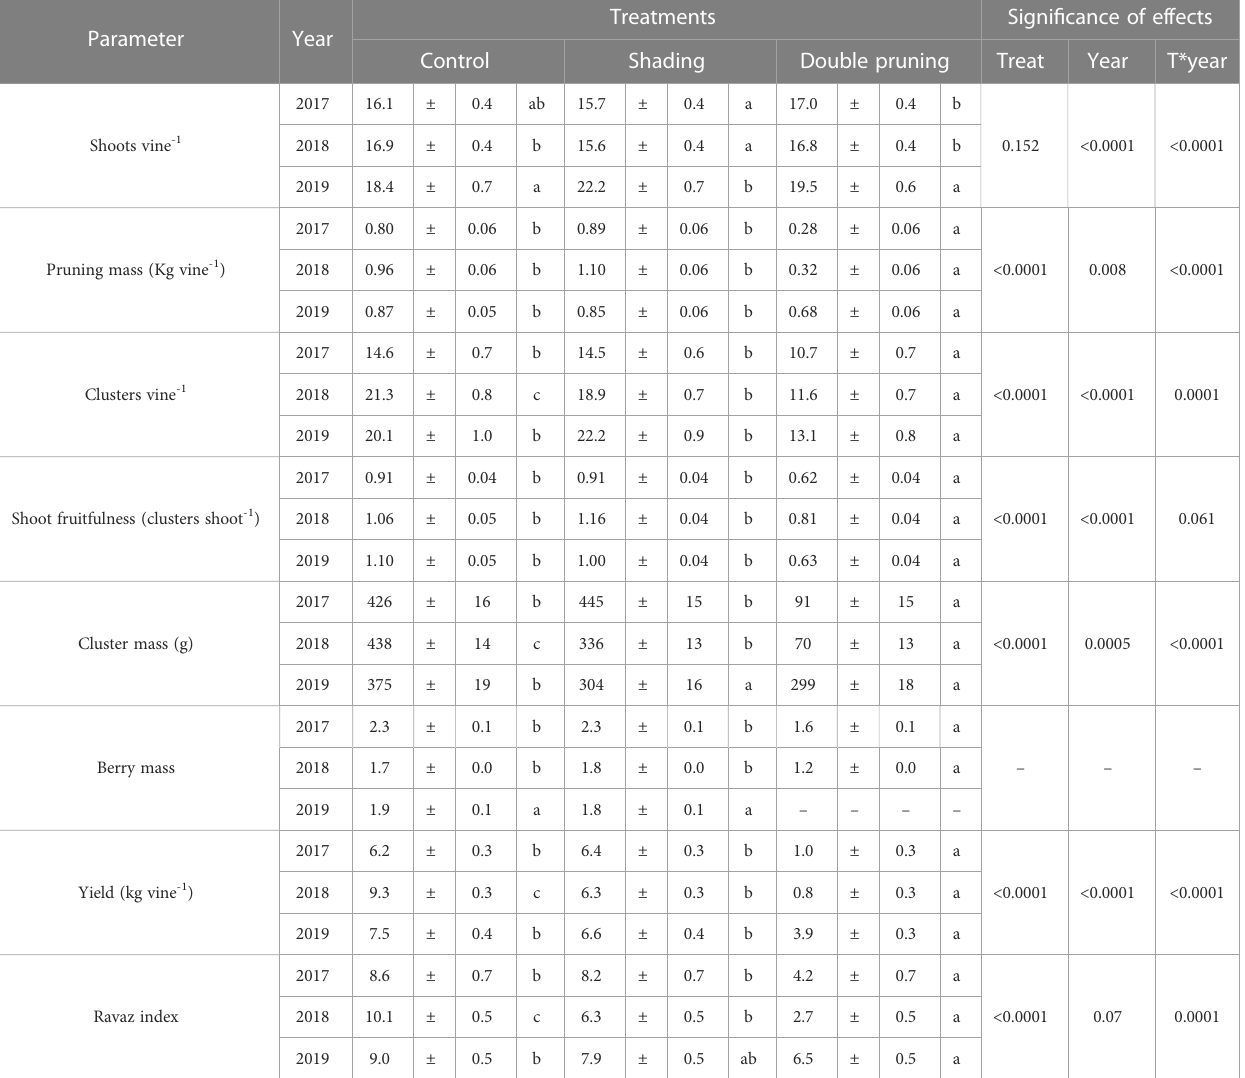
TABLE 1 Average values of vegetative growth and yield components over the 3 years of the experiment in ‘ Macabeo ’ grapevines subjected to different